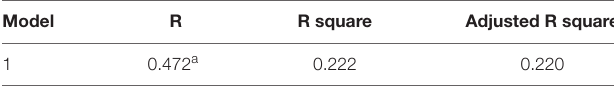
TABLE 3 | Model summary for Chinese EFL PC and JC.